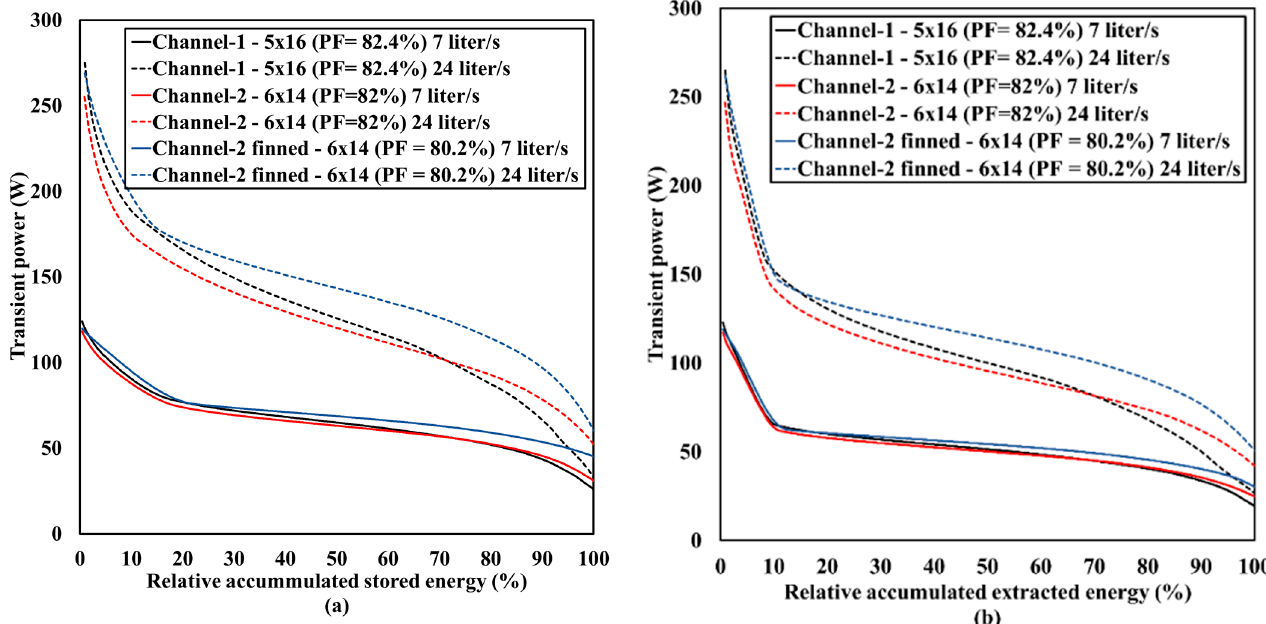
Figure 9. Transient power as a function of relative accumulated energy flow rates of 7 and 24 L/s: ( a ) melting-Tin = 30 °C, ( b ) solidification-Tin = 15 °C.